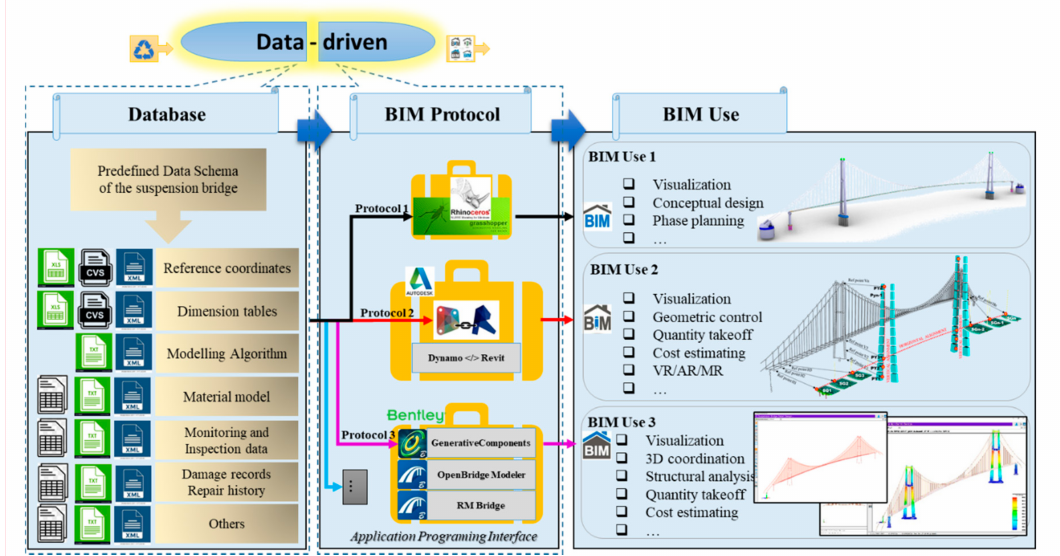
Figure 6. The data-driven design process for various BIM